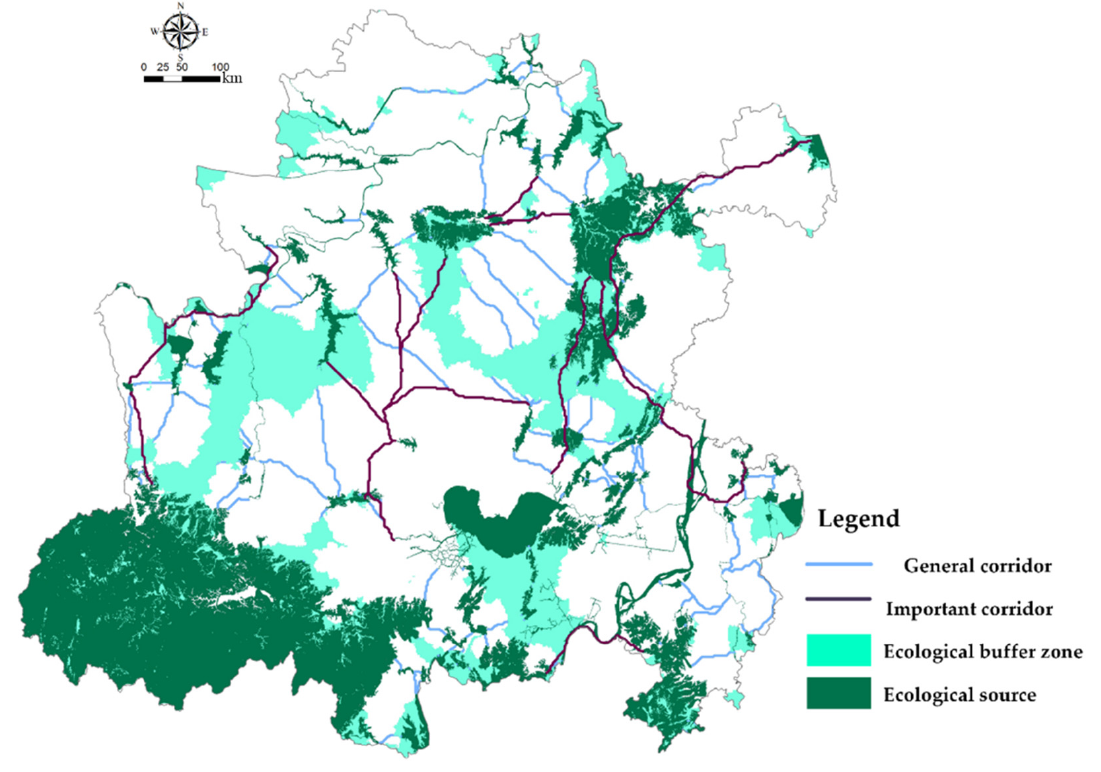
Figure 8. Construction of ecological security pattern of Hefei Metropolitan Area.